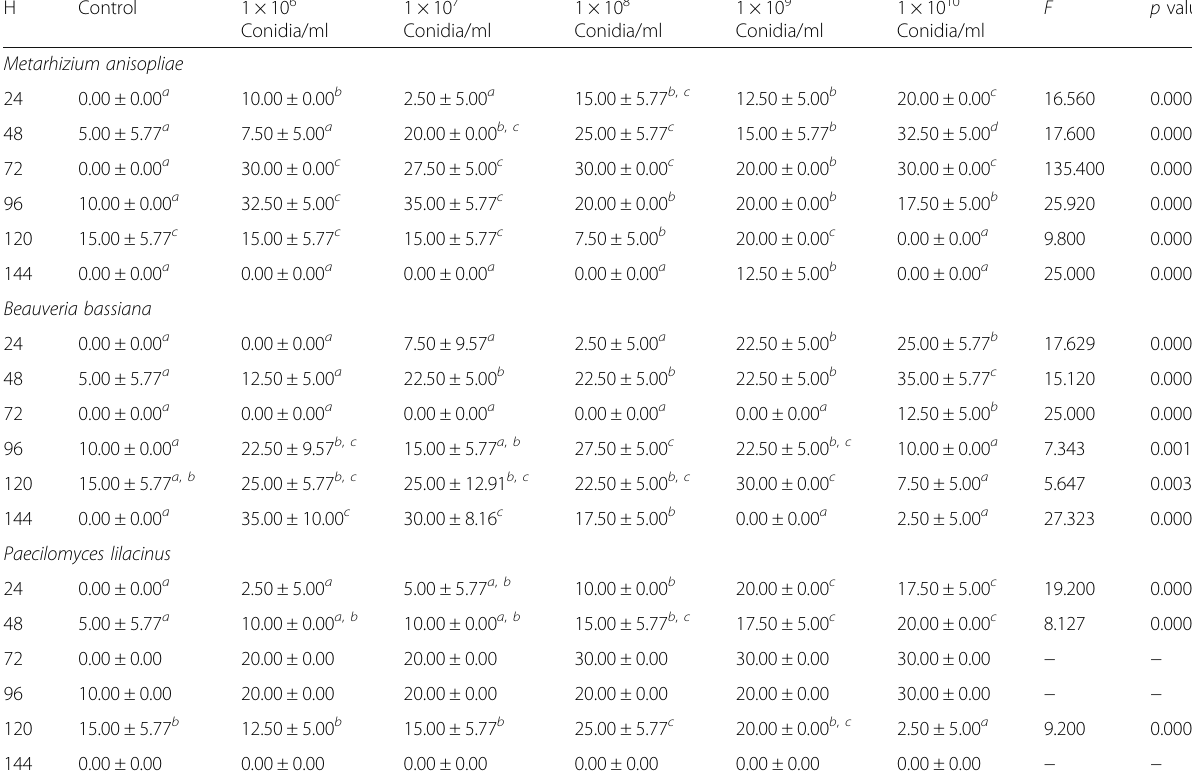
Table 3 Mean percentage of mortality (±SD) of Ceratitis capitata adults at different treatment times (h) using different concentrations of Metarhizium anisopliae , Beauveria bassiana , and Paecilomyces lilacinus